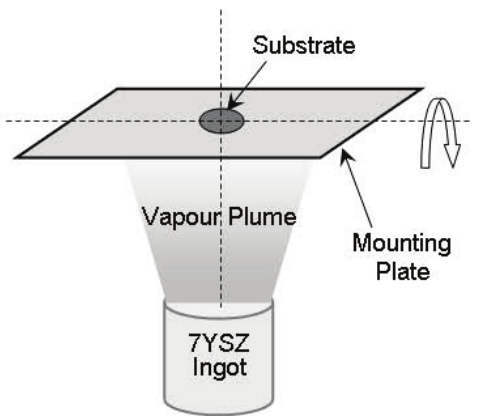
Figure 1. Schematic representation of the placement of the sample (substrate) with respect to the vapour plume during coating process.